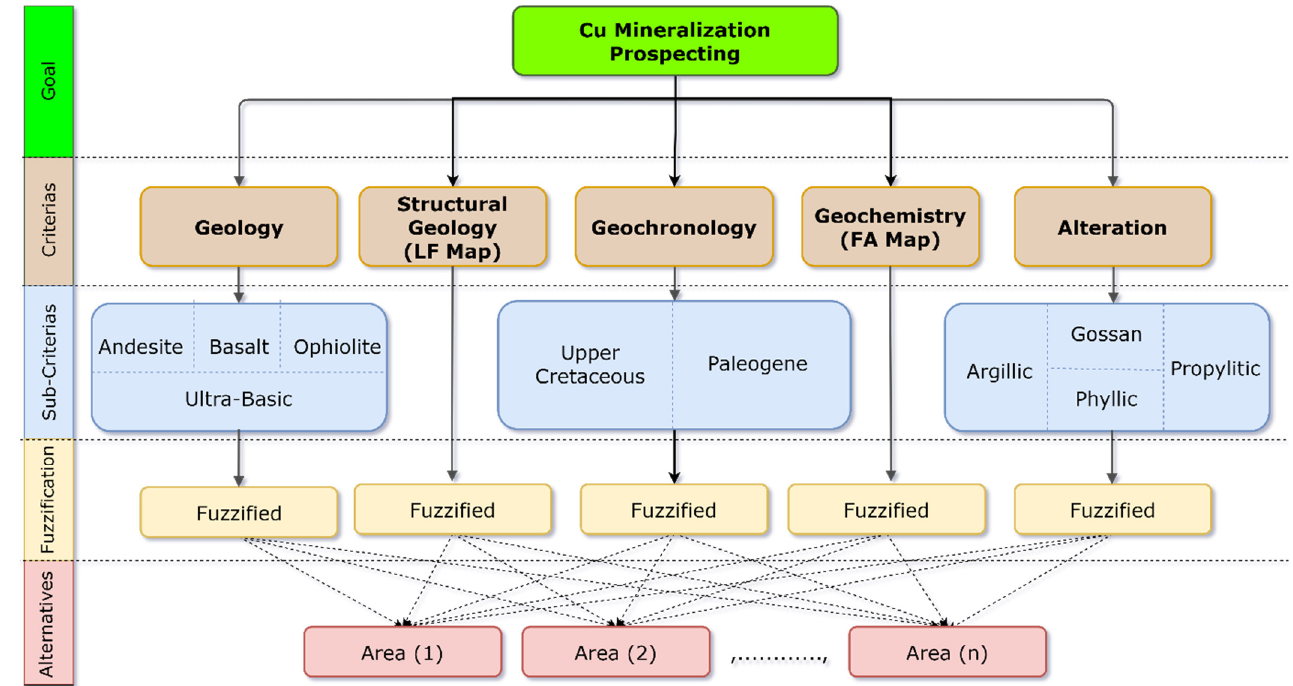
Figure 4. Hierarchical structure for integrated modeling of copper mineralization in the Sahlabad mining area based on the Fuzzy-AHP method.